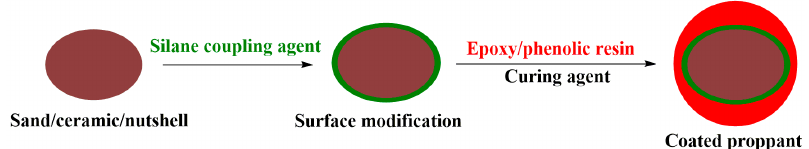
Figure 4. Schemes of the coating process of traditional proppant.